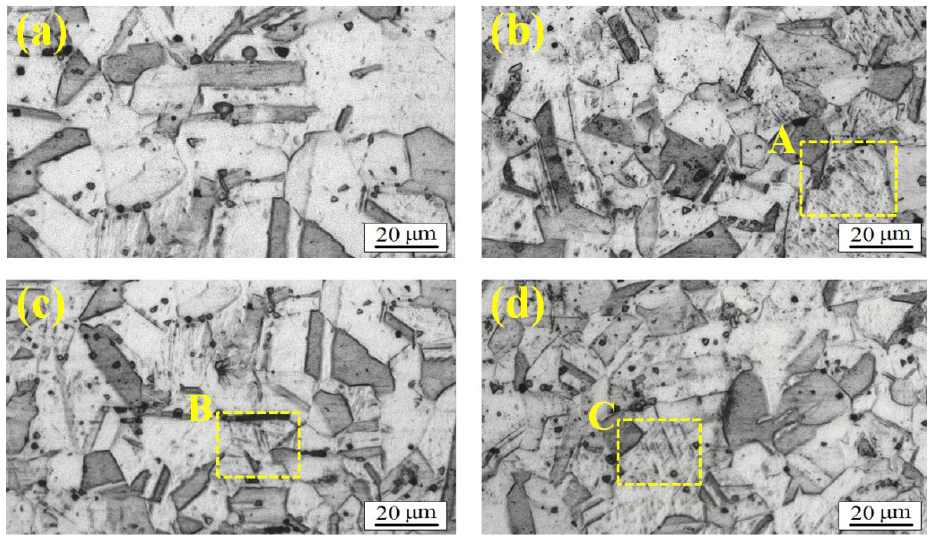
Figure 6. Typical metallographic observations in the top surface of as-machined specimen and three types of LSPed specimens. ( a ) As-machined specimen; ( b ) single LSP impact; ( c ) dual LSP impacts; and ( d ) triple LSP impacts.